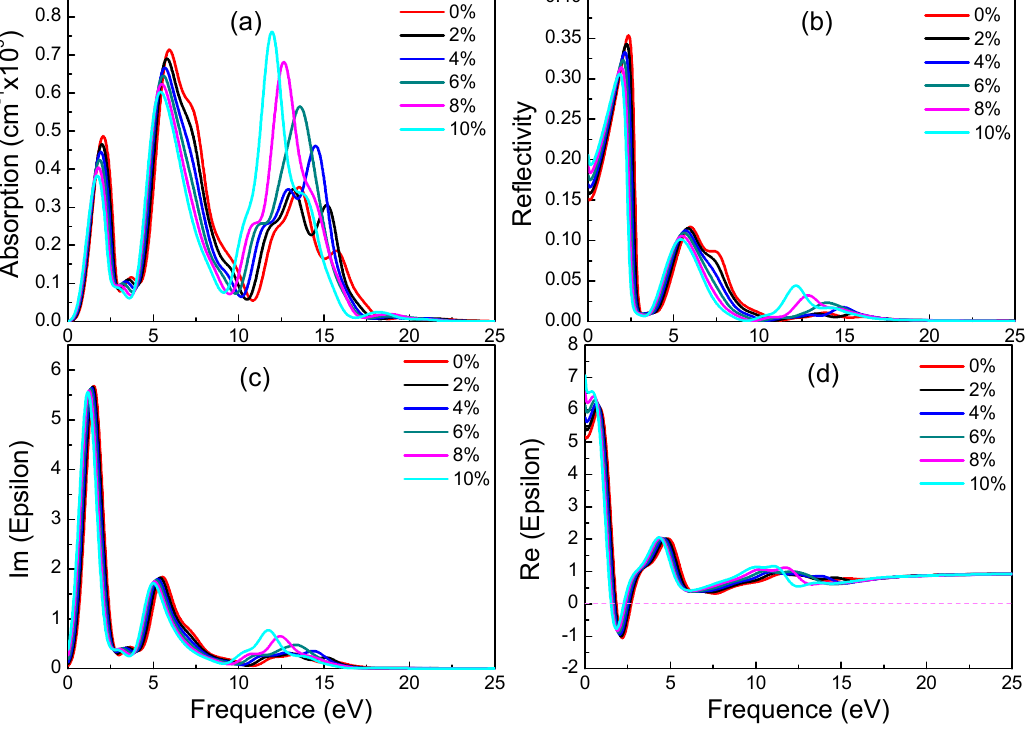
Figure 6. Absorption spectra ( a ), reflectivity ( b ), imaginary ( c ) and real ( d ) part of the dielectric constants of α -graphyne under different strains.